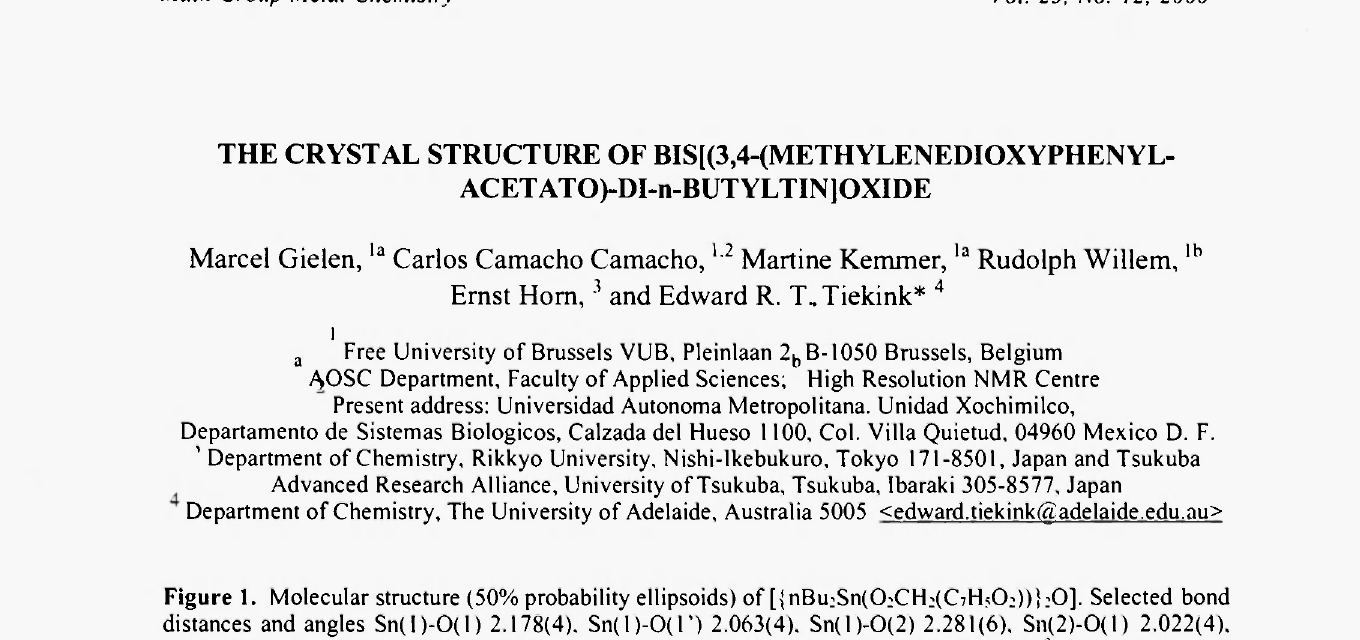
Figure 1. Molecular structure (50% probability ellipsoids) of [{nBu;Sn(0:CH : (C7H 5 0;))};0]. Selected bond distances and angles Sn(I)-0(l) 2.178(4). S n ( l ) - 0 (D 2.063(4). Sn(l)-0(2) 2.281(6), Sn(2)-0(1)